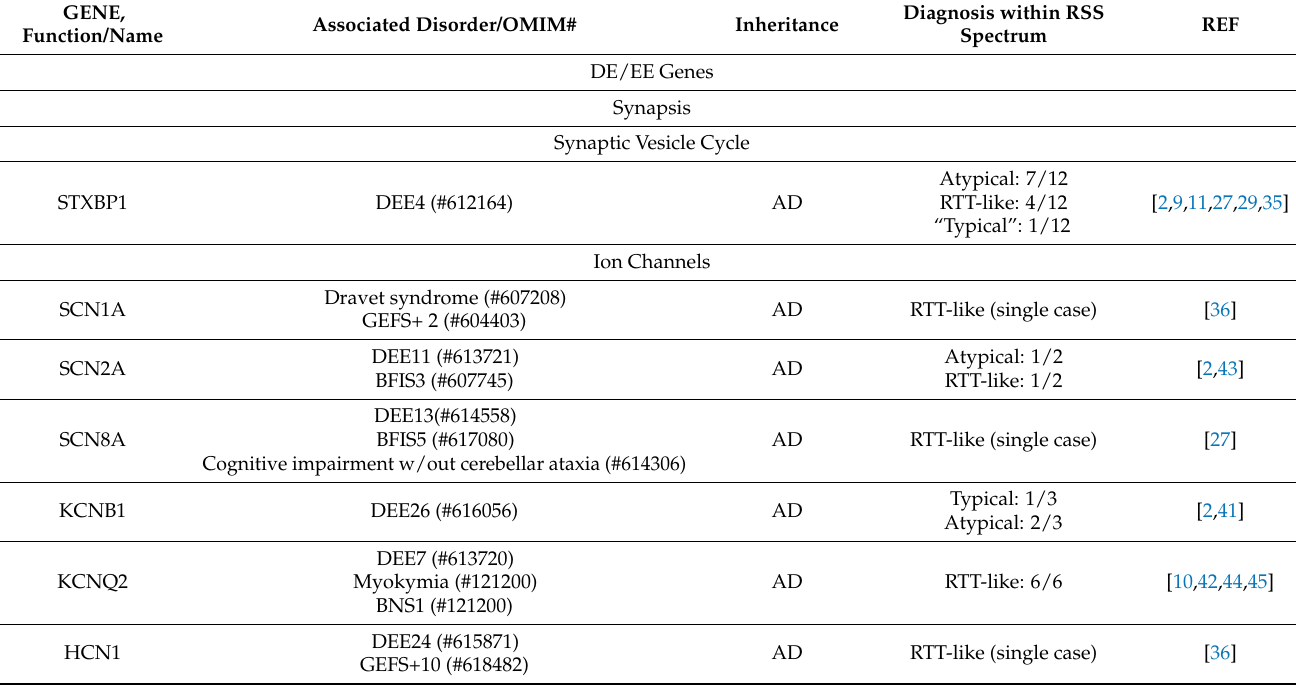
Table 3. Genes reviewed in this paper, with associated OMIM disorders, inheritance, reported clinical diagnoses within the Rett syndrome spectrum, number of patients and reference. As per OMIM nomenclature, the symbol “#” before a number indicates a descriptive entry (a phenotype), while “*” indicates a